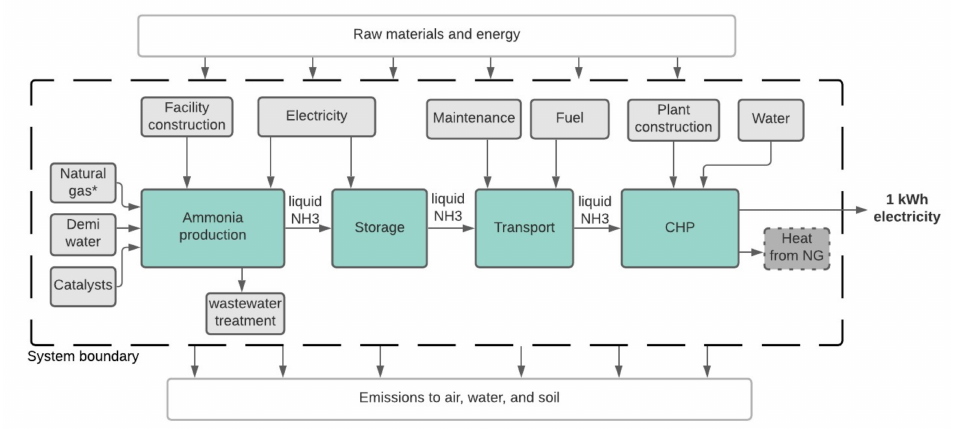
Figure 2. The system boundary of the ammonia-based electricity generation system. The CHP has a thermal output of 2.58 kWh per 1 kWh of electricity generated, which can be used as industrial or district heating. This heat was integrated into the model as a displacement of heat from natural gas. * Natural gas is the only input in the production of ammonia via SMR. The quantitative values of materials and energy flows are described in detail in Tables S1 to S3 of the Supplementary